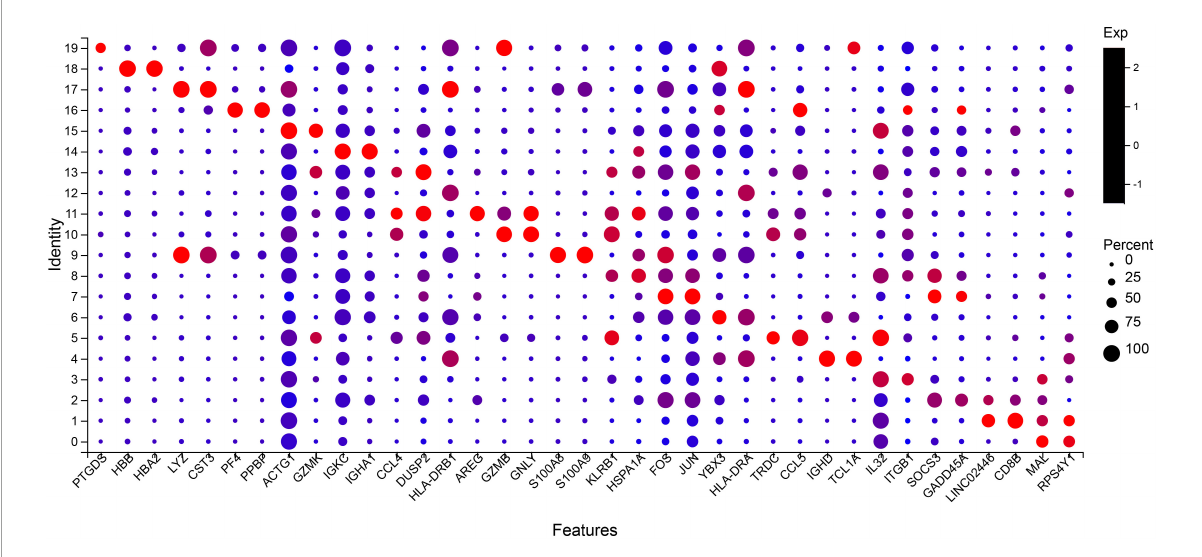
FIGURE2 Select the two most significant genes in each cluster to display in the bubble plot. Dot size indicates the proportion of cells in cluster expressing each marker gene, and color indicates the relative expression level (low to high reflected as blue to red). Top two marker genes are ordered as cluster 19 ( PTGDS and HBB ) to cluster 0 ( MAL and RPS4Y1 ). Naive CD4 + T cells: 0, 7; Naive CD8 + T cells: 1, 2; CD4 + Central Memory: 3, 8; CD8 + Effector Memory: 5, 13; Naïve B cells: 4, 6, 12; Mature B cells class switched: 14; Monocytes: 9; Mature NK cells_CD56 + CD16 + CD3-: 10, 11, 19; Erythroid_CD34- CD71 + GlyA +: 16, 18; Myeloid Dendritic Cells: 17; NA: 15.